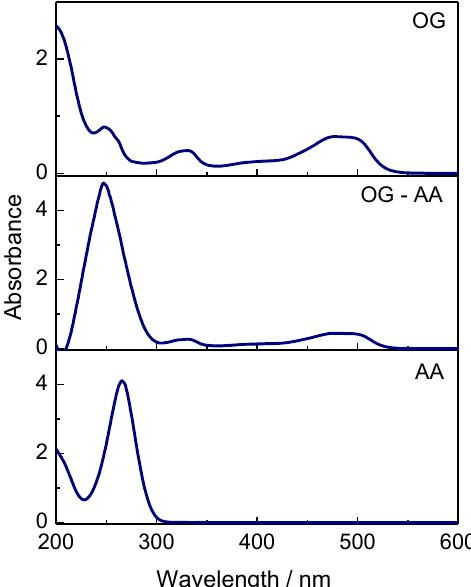
Figure 1. Electronic spectra of aqueous solutions of OG (25 µ M), OG and AA (25 µ M OG & 0.5 mM AA), and AA (0.25 mM).